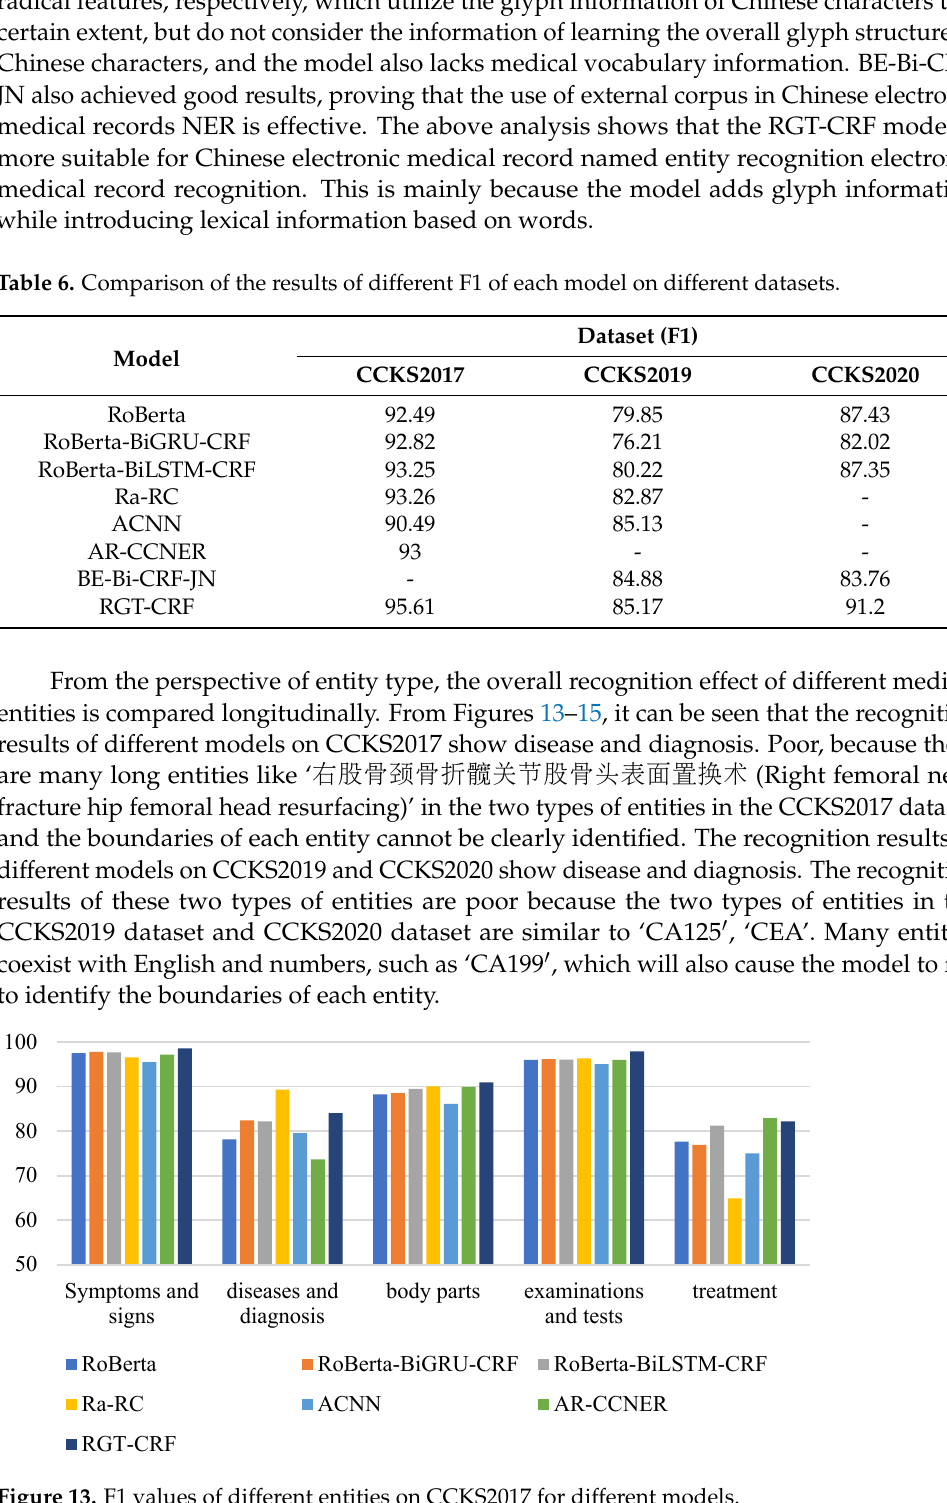
Figure 14. F1 values of different entities on CCKS2018 for different models. Figure 15. F1 values of different entities on CCKS2020 for different models. To make the comparative results more convincing, a further hypothesis test was per- formed by calculating p-values using the t-test method, and p -values smaller than the sig- nificance level (usually 0.05) were considered statistically significant. Table 7 shows the